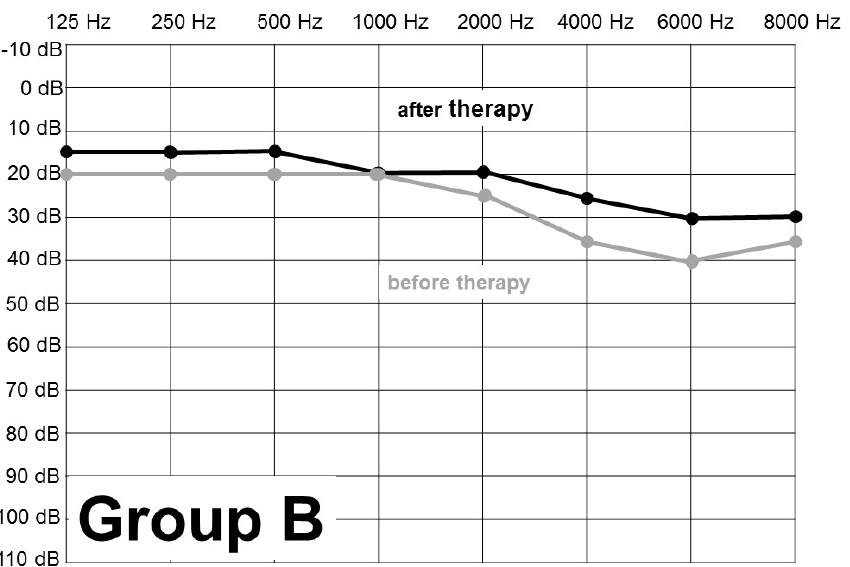
Figure 2. PTA before and after the treatment of AAT—Group B—civilian persons (n = 58).